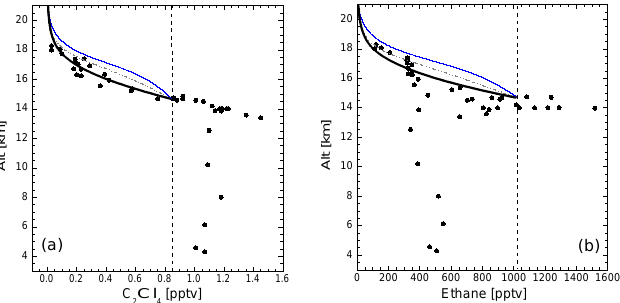
Fig. 8. Vertical distributions of (a) C 2 Cl 4 and (b) ethane. The 1-D model results using the optimum OH profile shown in Fig. 6 (blue solid lines) overestimate the observations denoted by black solid circles. The difference between the simulation and observation should correspond to the reaction with Cl atoms, but the GMI-derived Cl atoms are not sufficient (gray dotted lines). The best matches are generated by adjusting 24-h average value for Cl concentrations between 14km and 18.5 km and are represented by black solid